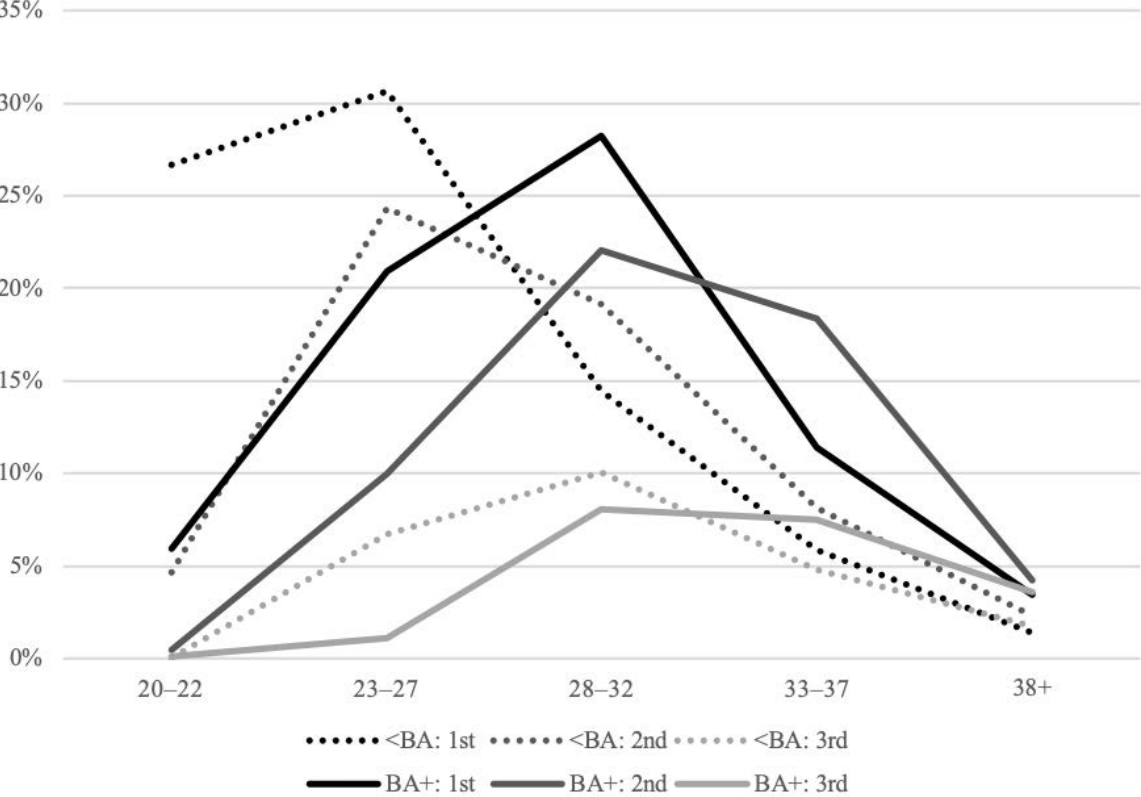
Figure 1: Percentage of women with first, second, and third births in each age range, by education. Source: National Longitudinal Survey of Youth 1979, 1979–2014. Weighted using baseline weights. BA, bachelor’s